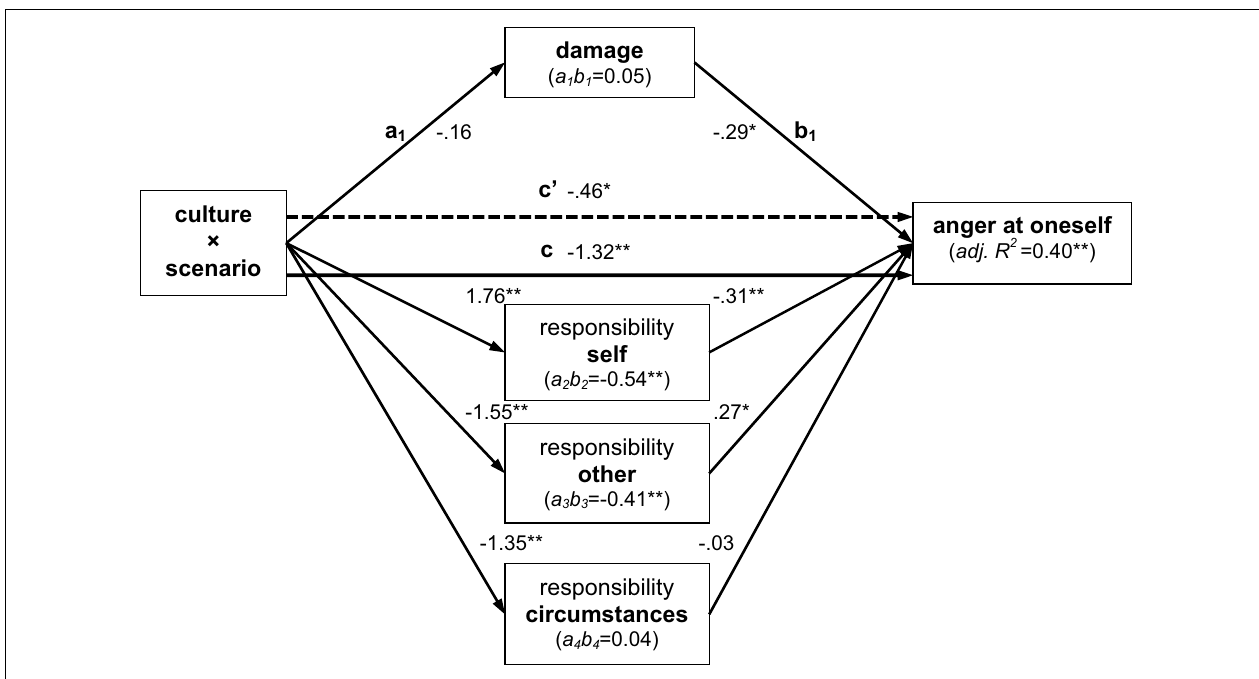
FIGURE 6 | Results of mediated moderation analyses for anger at oneself across scenarios SC and OC from triplet 2. Results indicate partial mediation of the moderating effect of culture by perceived self- and other-responsibility; all conventions as in Figure 4 .